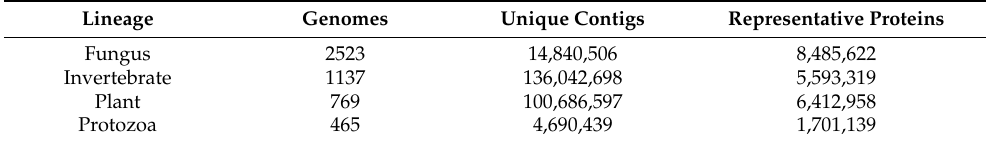
Table 1. A summary of the number of genomes, unique nucleotide contigs, and representative protein coding sequences present in each of the non-target